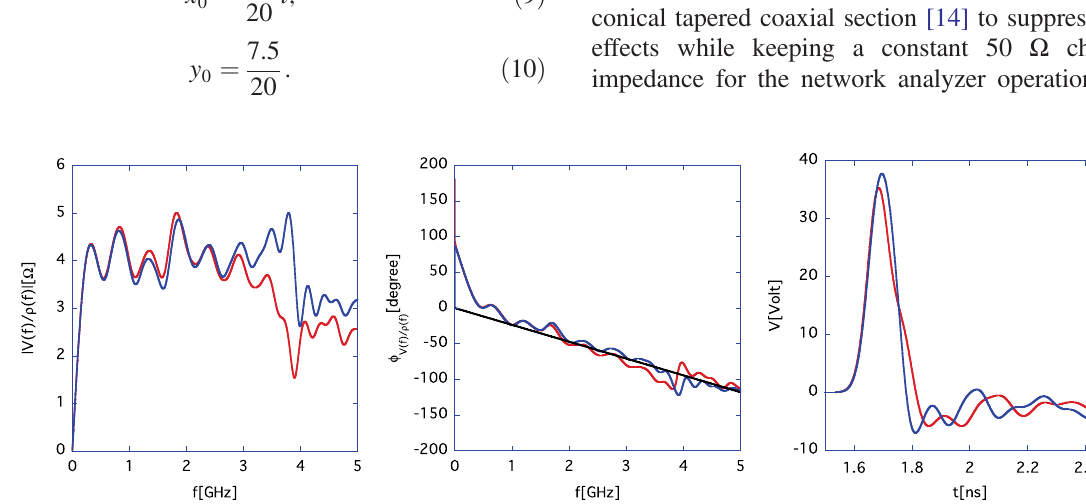
FIG. 17. The simulation result of the concave pentagon electrode. The blue and the red lines show the results with and without apron,